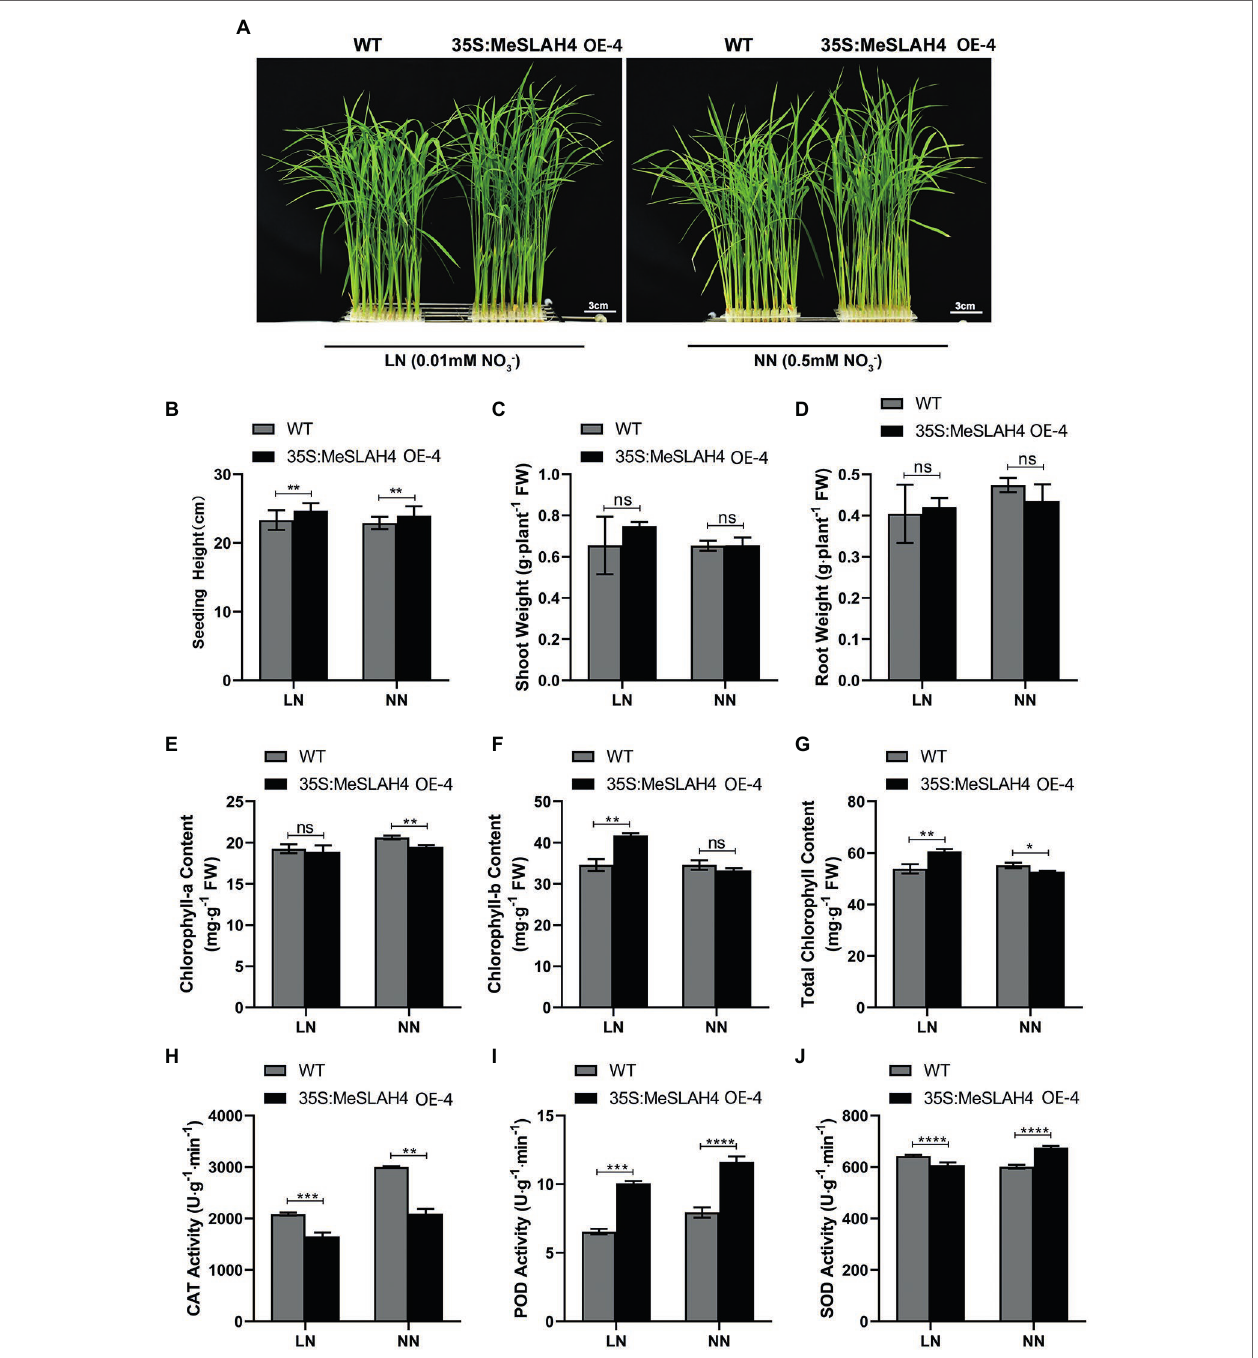
FIGURE 4 | Morpho-physiological traits of wild type and OE lines under different nitrogen conditions. (A) Phenotypes of wild type (WT) and MeSLAH4-OElines (35S:MeSLAH4) grown in hydroponic medium with different nitrate concentrations for 14 days. Bar = 3.0 cm. (B) Plant height (cm). (C) Shoot weight (g plant − 1 FW). (D) Root weight (g plant − 1 FW). (E) Chlorophyll-a content (mg. g − 1 FW). (F) Chlorophyll-b content (mg. g − 1 FW). (G) Total chlorophyll content (mg. g − 1 FW). (H) CAT activity (U.g − 1 .min − 1 ). (I) POD activity (U.g − 1 .min − 1 ). (J) SOD activity of seedings (U.g − 1 .min − 1 ). The letters “ns” indicate non-significant differences while *, **, ***, and **** represent significant differences at p < 0.05, p < 0.01, p < 0.001, p < 0.0001, respectively on one-way ANOVA